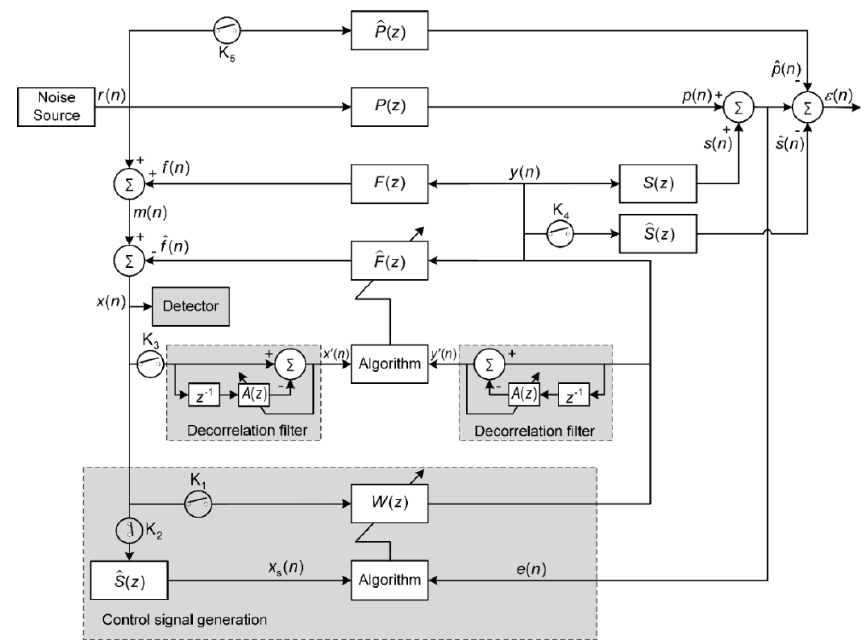
Figure 1. Schematic diagram of the proposed method for active control with online feedback path modelling using the control signal.